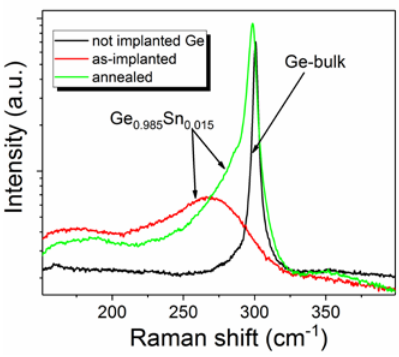
Figure 2. Micro-Raman spectra obtained from as-implanted and from annealed Ge wafers that were implanted with Sn. The Sn concentration in the layer is 1.5%. The spectrum from intrinsic bulk Ge is shown for the reference.